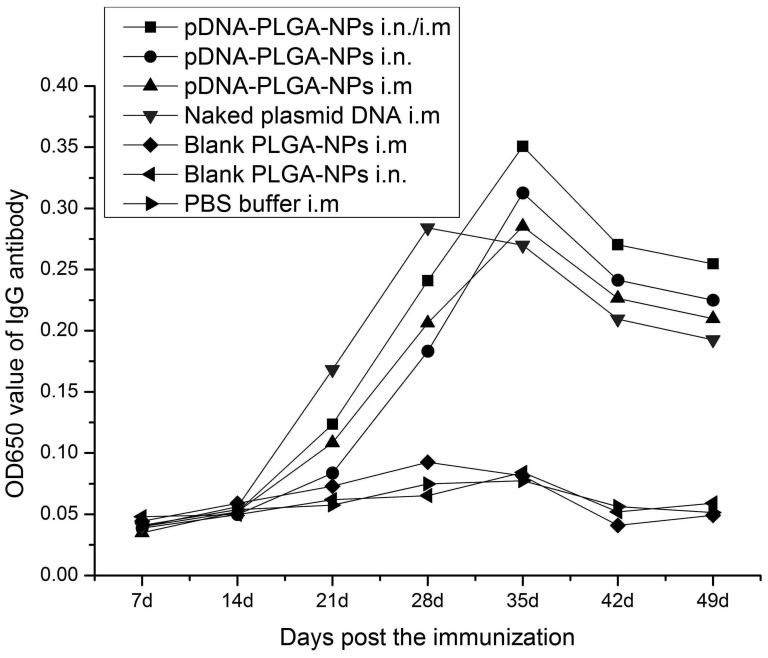
IgG antibody titers in serum of SPF chickens immunized with PBS (i.m.), blank PLGA-NPs (i.m.), blank PLGA-NPs (i.n.), and the naked plasmid DNA (i.m.), pFNDV-PLGA-NPs (i.m.), pFNDV-PLGA-NPs (i.n.) or pFNDV-PLGA-NPs (i.m./i.n.).IgG antibody titers were presented as mean ± SD of five experiments. Data with different small letters show significant difference (p<0.05).